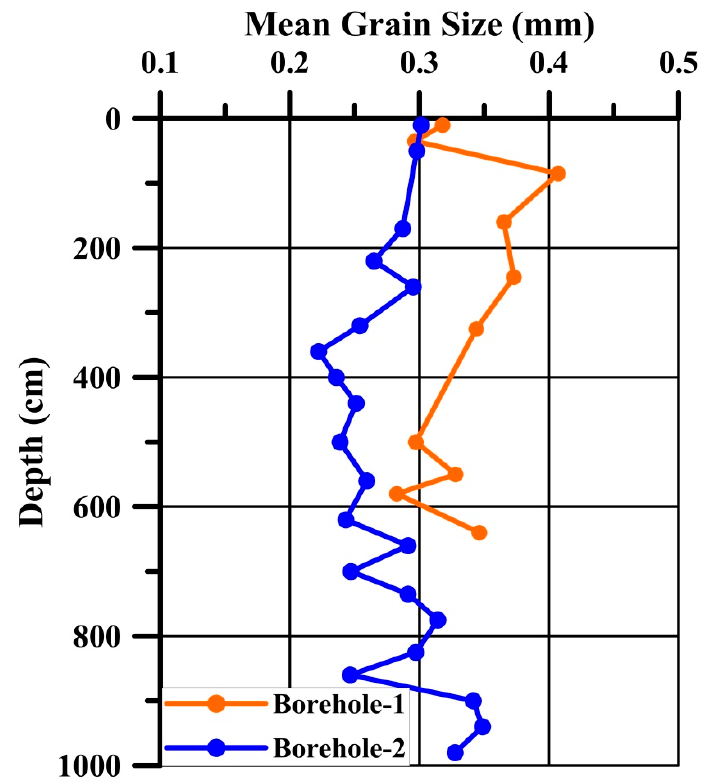
Figure 7. Mean grain size profiles of the two boreholes.